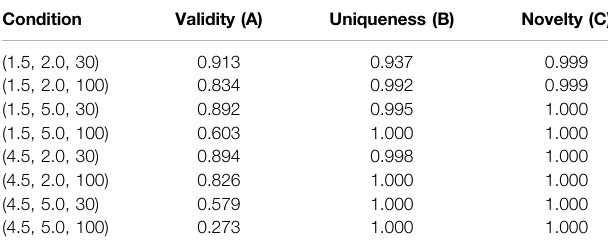
TABLE 3 | Performance of CRAG on Conditional Molecular Generation on the ZINC dataset, where the three conditions of logP, SAS, and TPSA are simultaneously